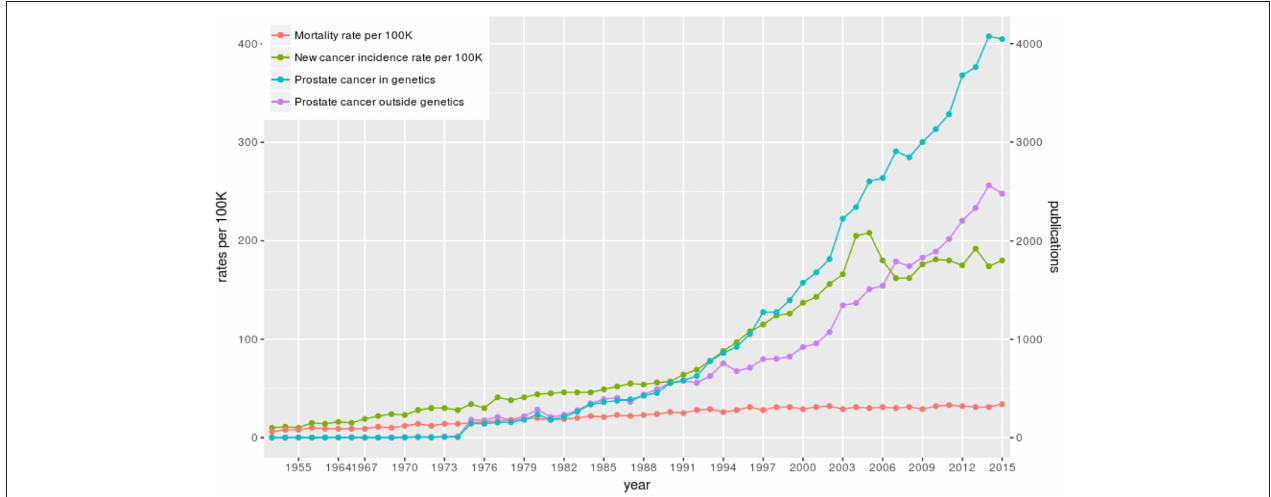
FIGURE 3 | The number of published articles about prostate cancer in the world and prostate cancer statistics in Finland. The blue curve shows the number of published articles about prostate cancer in genetics and the violet curve shows the number of published articles about prostate cancer outside genetics. In red the mortality and in green the incidence rate per 100,000 is shown for Finland.